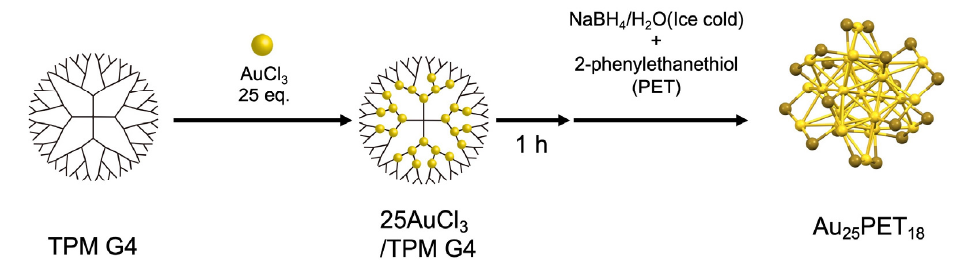
Figure 1. Synthetic scheme of an Au 25 PET 18 superatom using the TPM G4